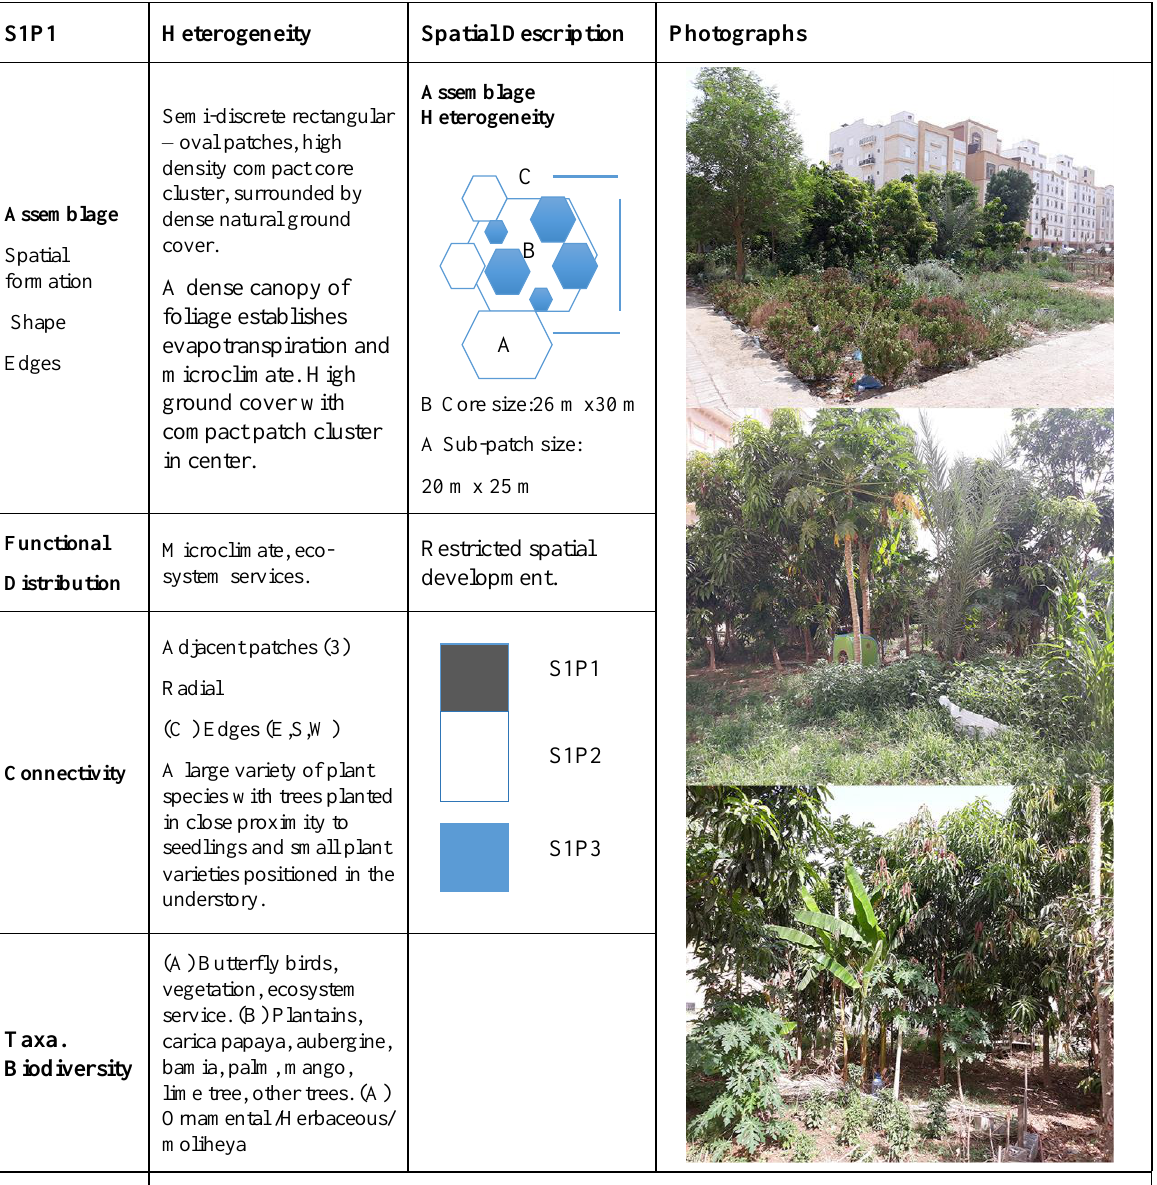
Table 2. Description of constructed habitat patch types found in Jeddah Saudi